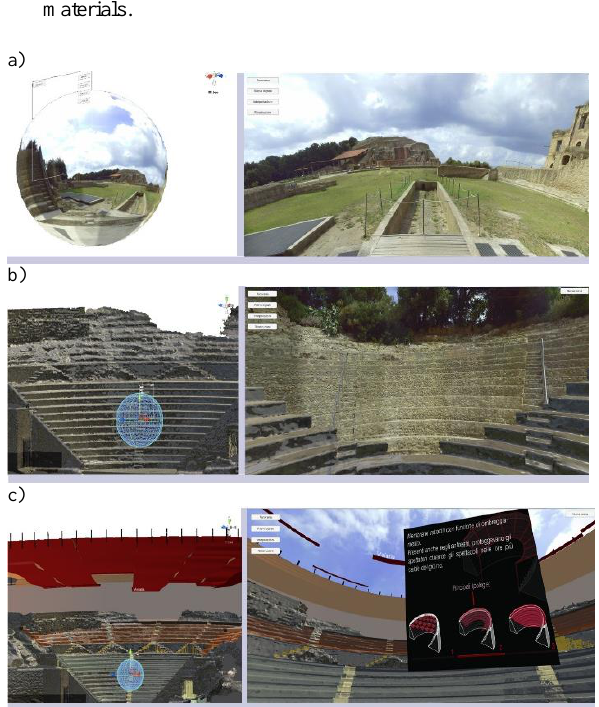
Figure 13: Unity 3D engine: scene and gaming view - 360° panoramic 531 images (a); 3D reality-based data (b); 2D information overlapped onto